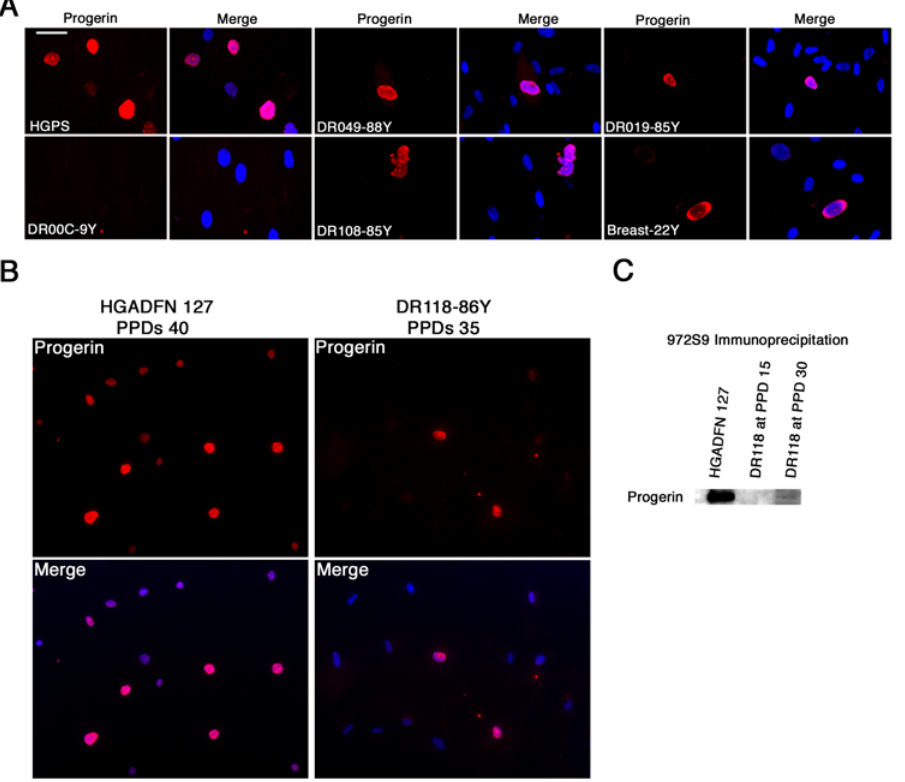
Figure 2. Progerin expression in primary dermal fibroblast cultures. A , Immunofluorescence microscopy on primary dermal fibroblasts from an HGPS subject and unaffected individuals of indicated ages with rabbit monoclonal anti-progerin antibody. B , Immunofluoresence detection of progerin in HGADFN 127 (HGPS individual) and DR118 (86-year-old individual) at late PPDs. C , Western blot analysis of nuclear protein extracts derived from fibroblast cultures HGADFN 127 (HGPS) at PPD 20 and DR118 (86-year-old female) at PPD 15 and 30, respectively, were immunoprecipitated with anti-progerin mAb 972S9 and the corresponding Western blot was probed with the same antibody.